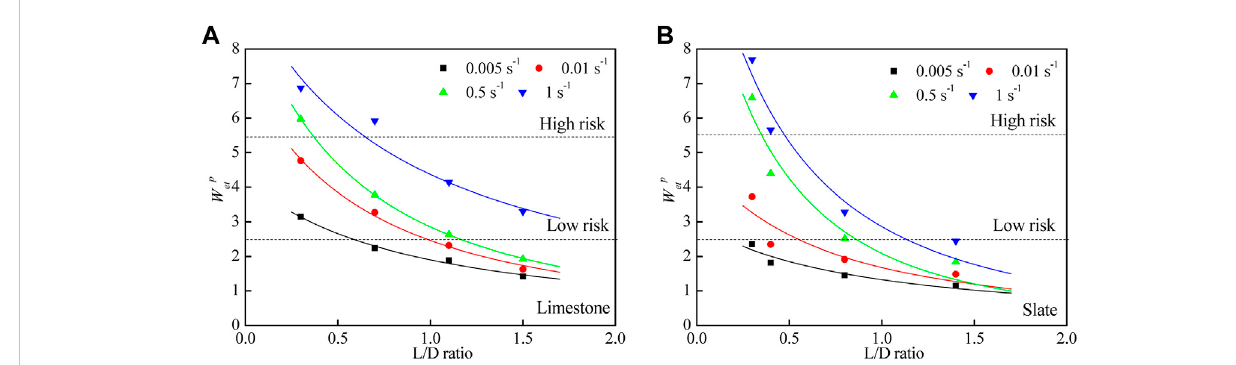
FIGURE 10 Correlation between W p et and the L/D ratio for (A) Limestone and (B) Slate.